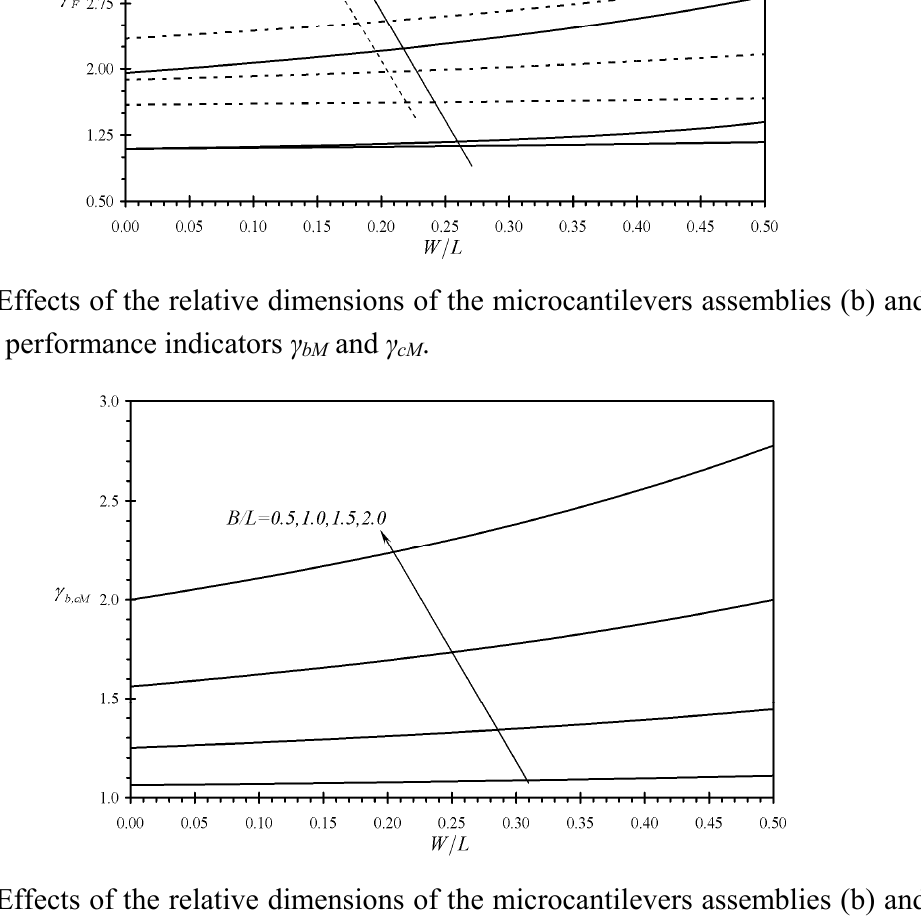
and γ b Δσ c Δσ